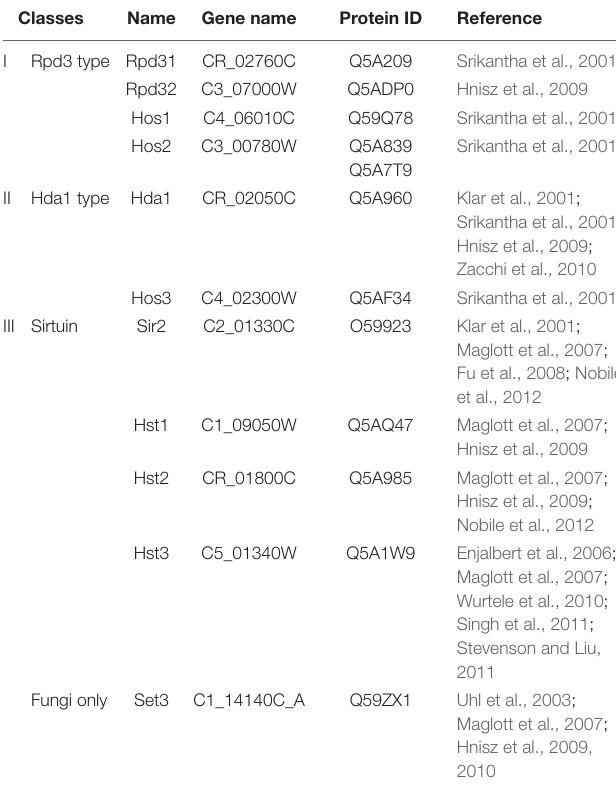
in C. albicans , where it is important for morphogenesis (Nobile et al., 2014).